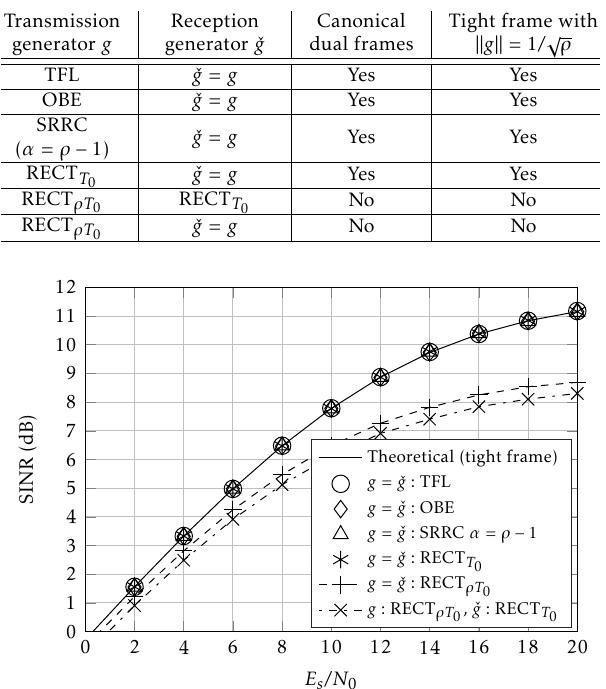
s /N 0 , with ρ = 16 / 15